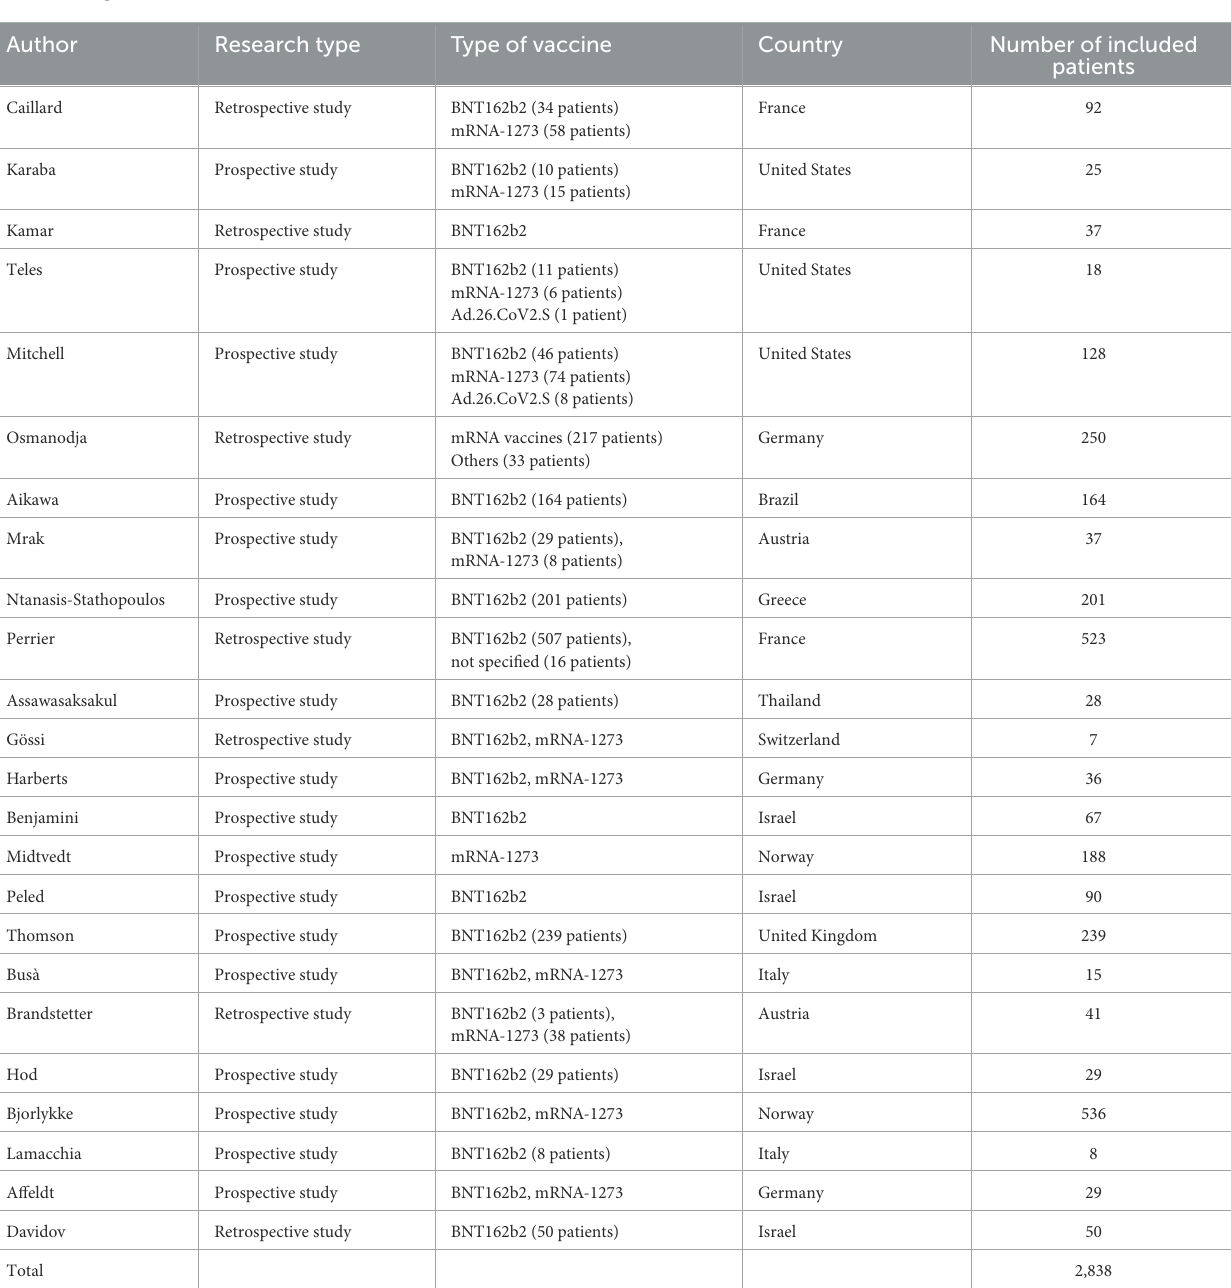
TABLE 2 Design and characteristics of the included